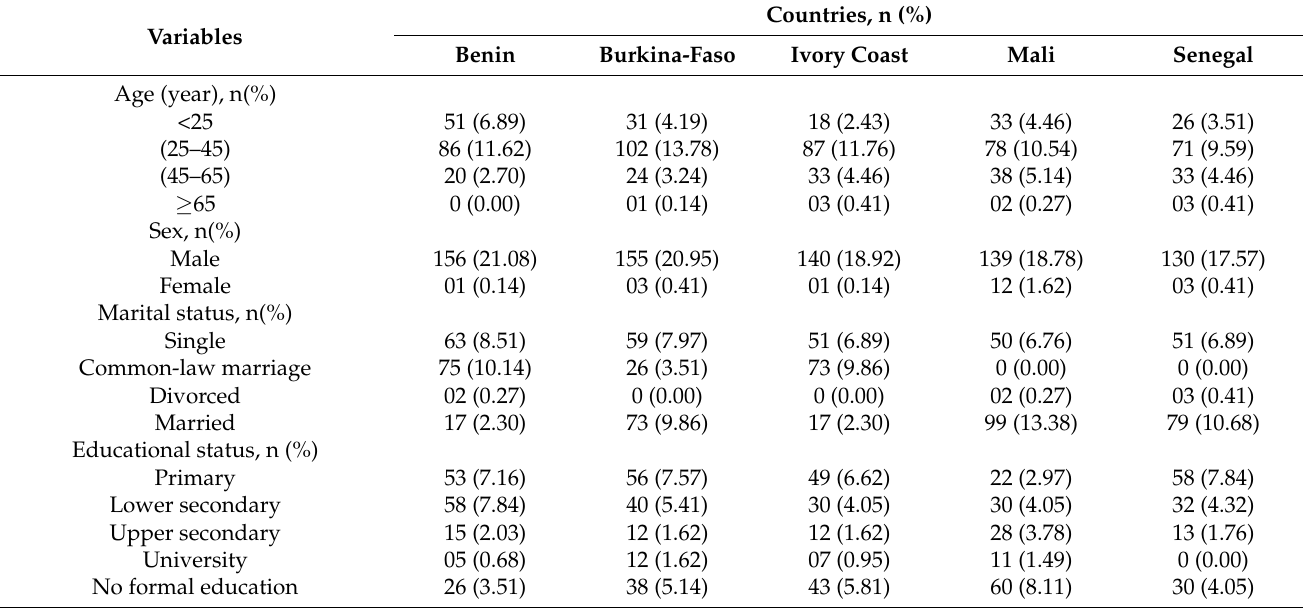
Table 1. Sociodemographic characteristics of e-waste